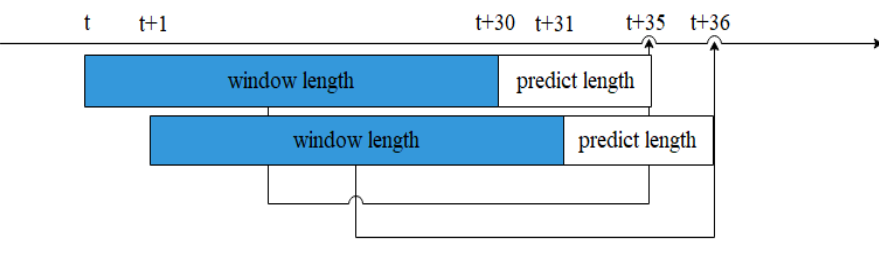
Fig. 7 . Window length and predict length